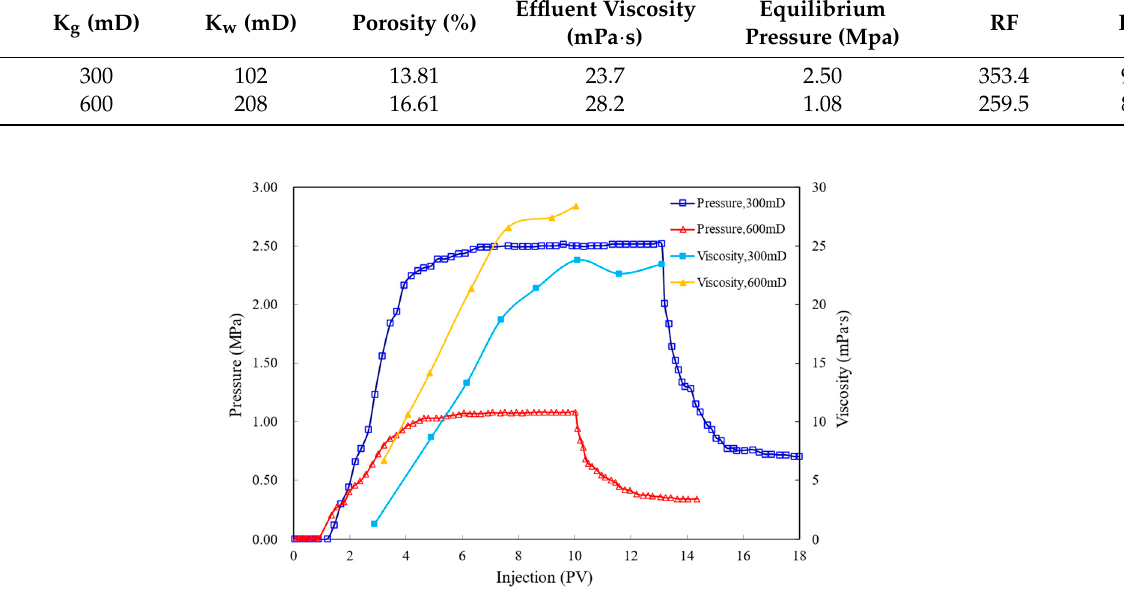
Figure 10. Pressure distribution diagram for polymer injection capability.